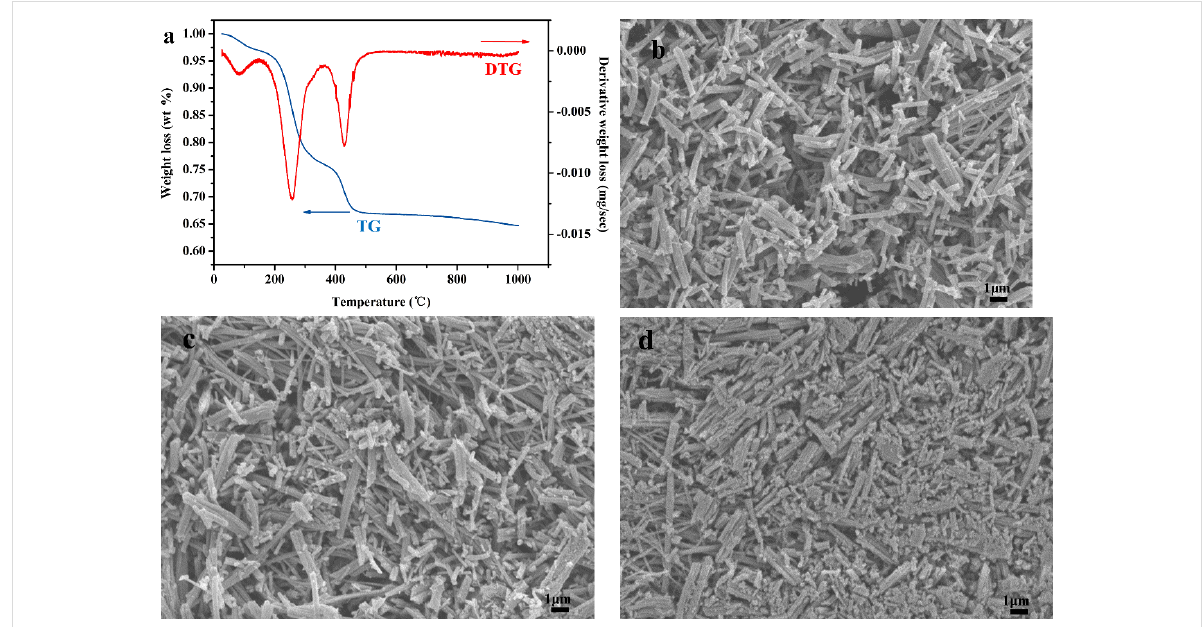
Figure 2: (a) TG and DTG curves of as-spun TiO 2 nanofibers; surface SEM images after calcination of sample A 2 (b), sample B 2 (c) and sample C 2 (d).